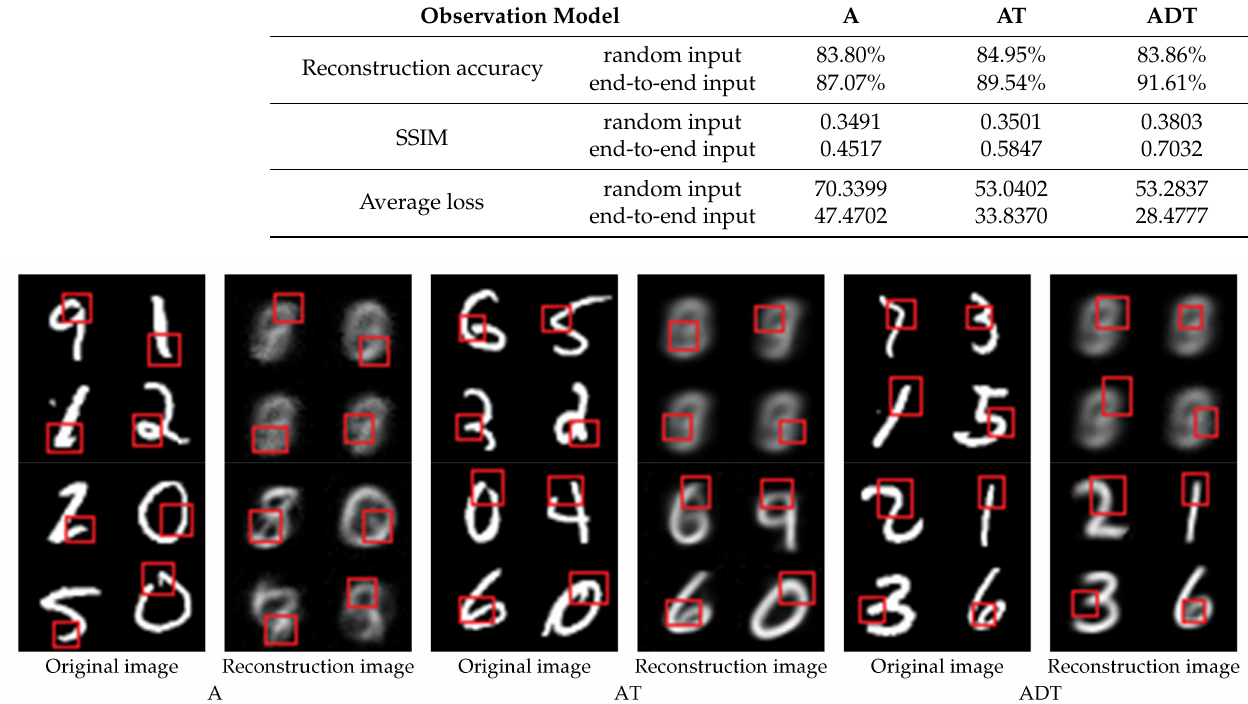
Figure 6. Comparison of reconstructed images of extreme